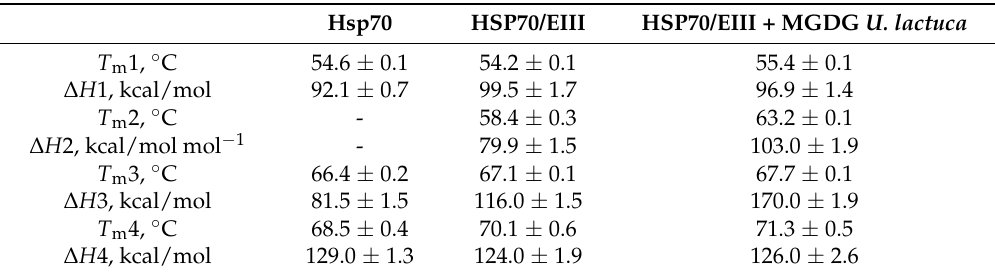
Figure 4. Temperature dependence of the excess molar heat capacity of Hsp70 ( a ), Hsp70/EIII ( b ) and Hsp70/EIII + MGDG from U. lactuca ( c ) in sodium phosphate buffer, pH 7.2 . The symbols are experimental data, while the dashed lines resulted from fitting the data to the two-state model, and solid lines are their sum. The scan rate was 1 K/min. Protein concentration was 0.5 mg/mL. Table 2. Arrhenius equation parameter values for peaks obtained in result of deconvolution of differential scanning calorimetry (DSC) thermograms of HSP70, HSP70/EIII alone and HSP70/EIII + MGDG from Ulva lactuca